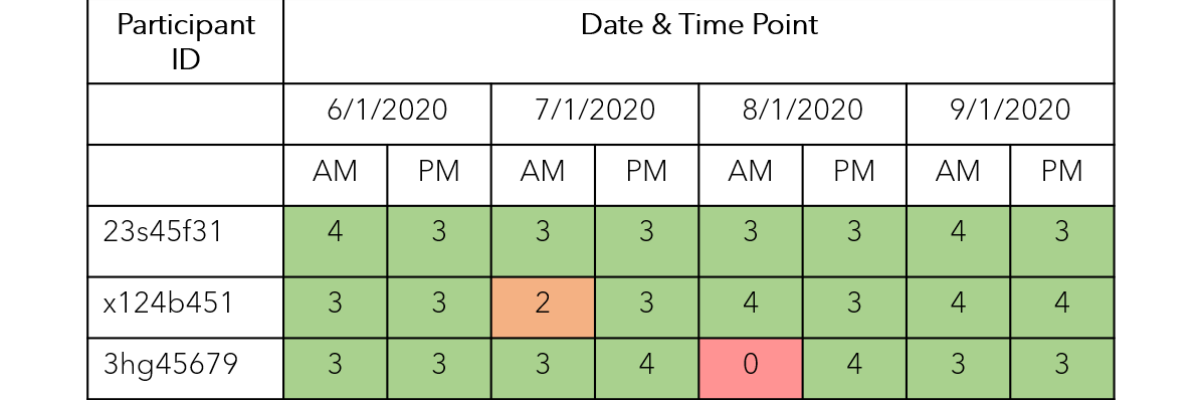
Figure 3. Example of the monitoring table presenting the number of acceptable tests per day/time point for each participant. Green cells: full adherence; orange cells: <3 acceptable measurements; red cells: missed